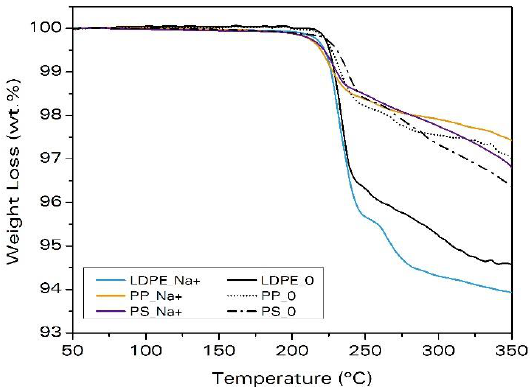
Figure 5. Weight loss measured by thermogravimetry due to the decomposition of the azodicarbonamide in samples with Na + .